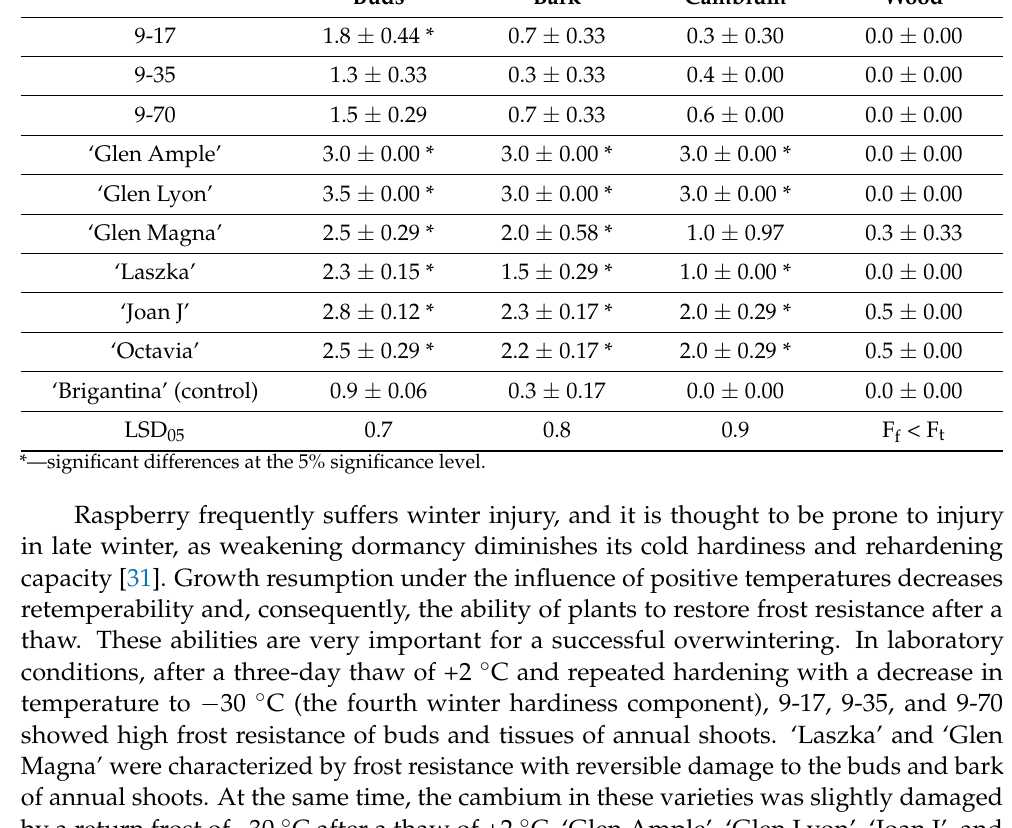
Table 5. Raspberry damage at − 25 ◦ C after a three-day thaw of +2 ◦ C (the third winter hardiness component), average for 2019–2021. Damage Degree, Points Genotype Buds